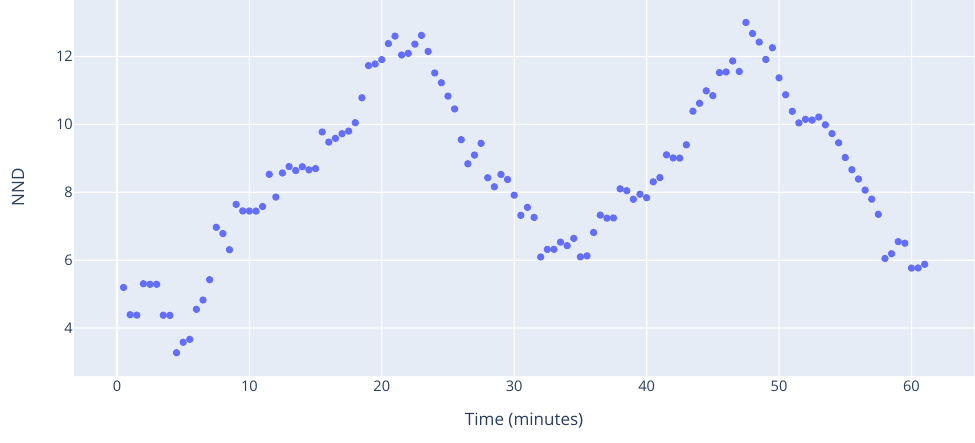
Figure 18. Nearest neighbour